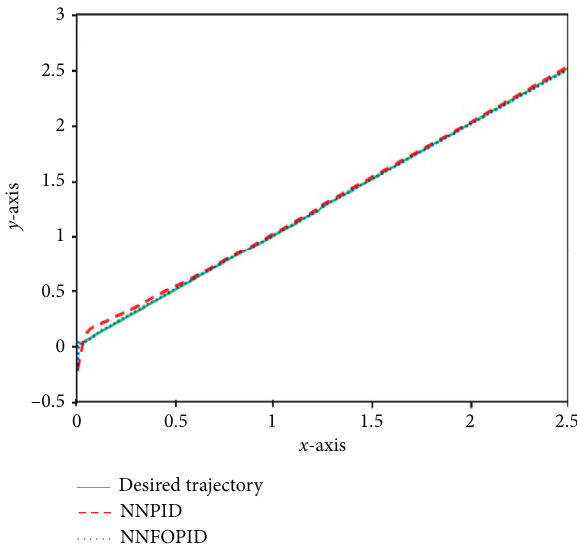
Figure 13: Desired and actual trajectories for the line trajectory.